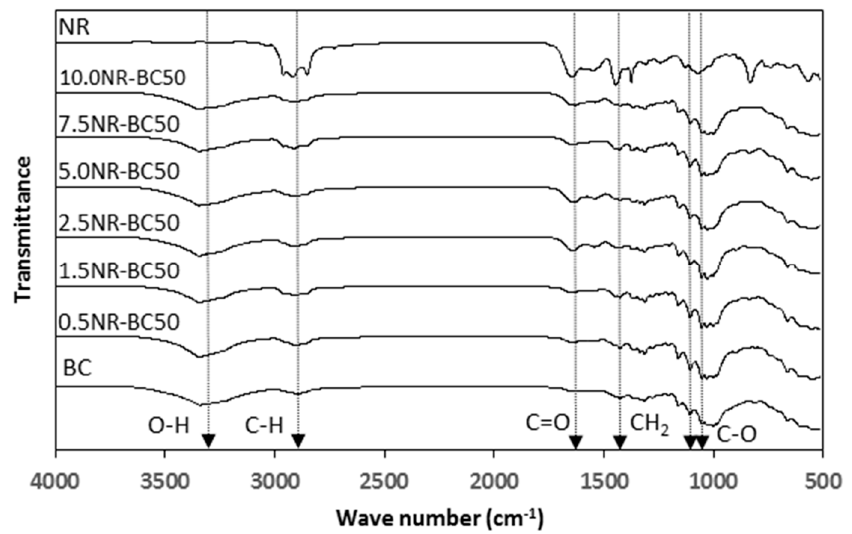
Figure 6. Fourier transform infrared spectroscopy (FTIR) spectra of BC, NR, and NR–BC films treated by the immersion in NRL of various concentrations at 50 °C.